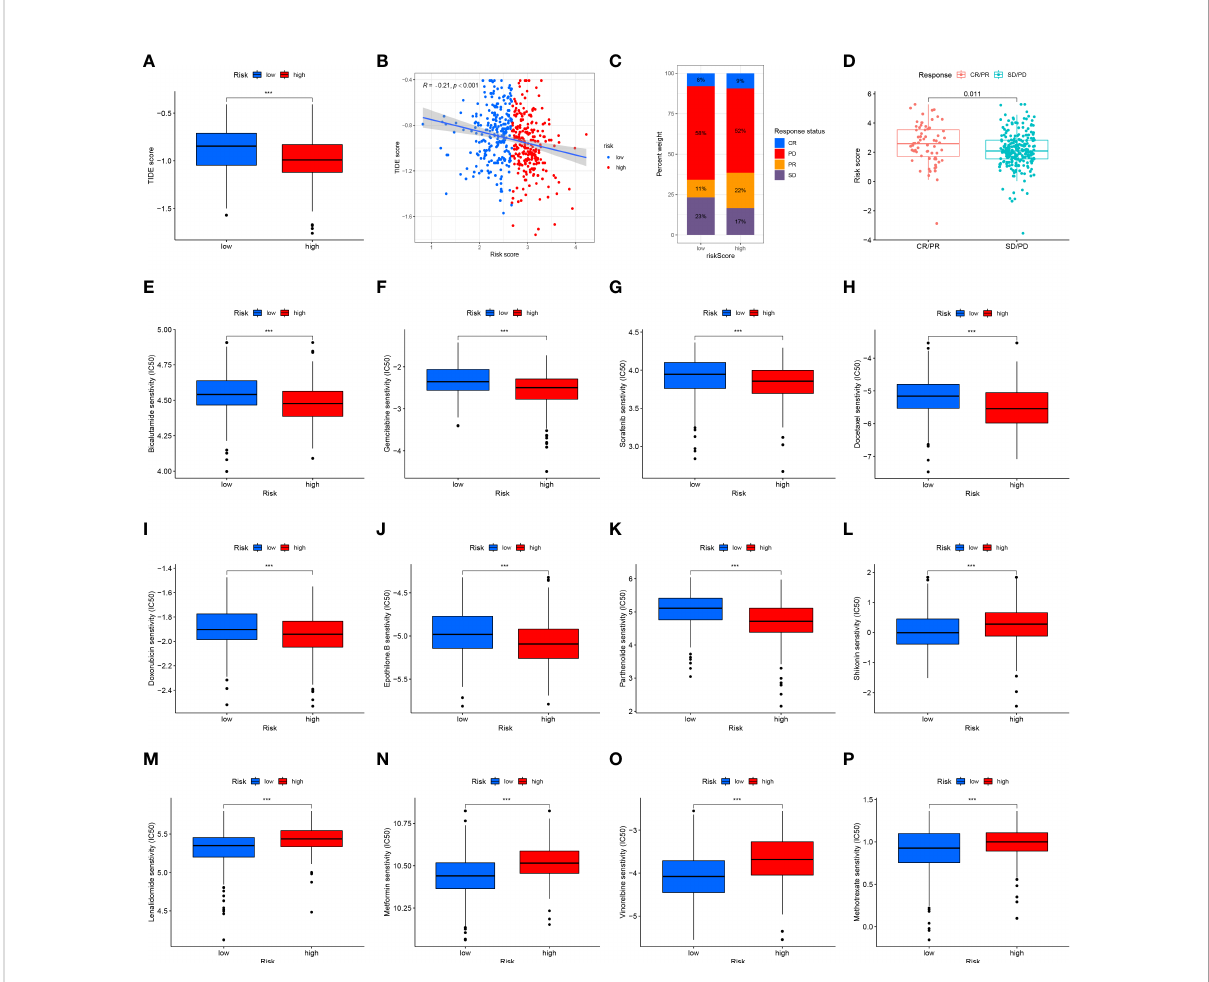
FIGURE 12 Risk score predicts responses to immunotherapy and chemotherapy. (A) Differences in the TIDE scores between the high-risk and low-risk groups in the TCGA dataset. (B) Scatter plots depicting the negative correlation between TIDE scores and risk scores in the TCGA dataset by the Spearman correlation analysis. (C) The proportion of patients in the IMvigor210 cohort with clinical response in high-risk and low-risk groups. CR, complete response; PD, progressive disease; PR, partial response; SD, stable disease. (D) Differences in the risk score among patients with different clinical responses in the IMvigor210 cohort. The box plot of the estimated IC50 for (E) bicalutamide, (F) gemcitabine, (G) sorafenib, (H) docetaxel, (I) doxorubicin, (J) epothilone B, (K) parthenolide, (L) shikonin, (M) lenalidomide, (N) metformin, (O) vinorelbine, and (P) methotrexate are shown between two groups in the TCGA dataset. The lower the IC50, the more sensitive the drug.